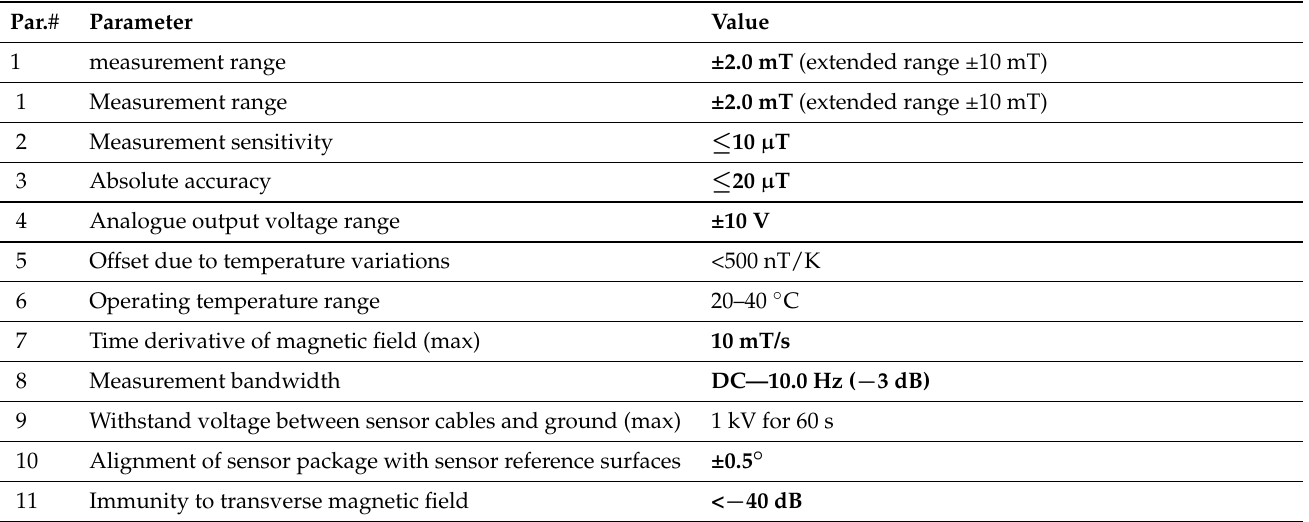
Table 1. Summary of sensor measurement specifications. The ones confirmed by the acceptance tests are highlighted in bold .